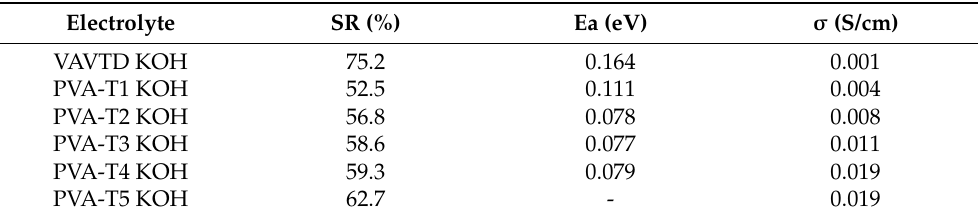
Table 2. Swelling ratio (SR), activation energy (Ea), and the conductivity ( σ ) values of PVA-VAVTD KOH electrolytes. σ values were obtained at T = 20 ◦ C. Electrolyte SR (%) Ea (eV) σ (S/cm) VAVTD KOH 75.2 0.164 0.001 PVA-T1 KOH